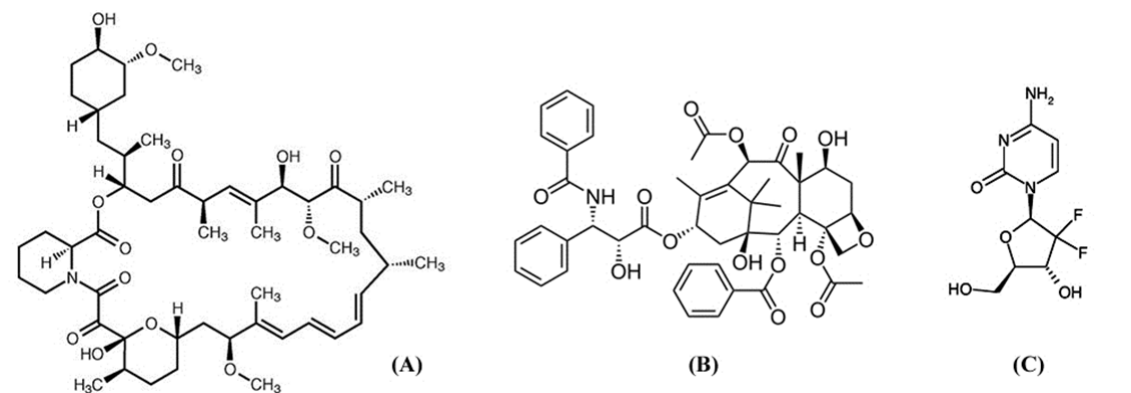
Figure 1. Chemical structures of antiproliferative drugs: sirolimus ( A ); paclitaxel ( B ); and gemcitabine ( C